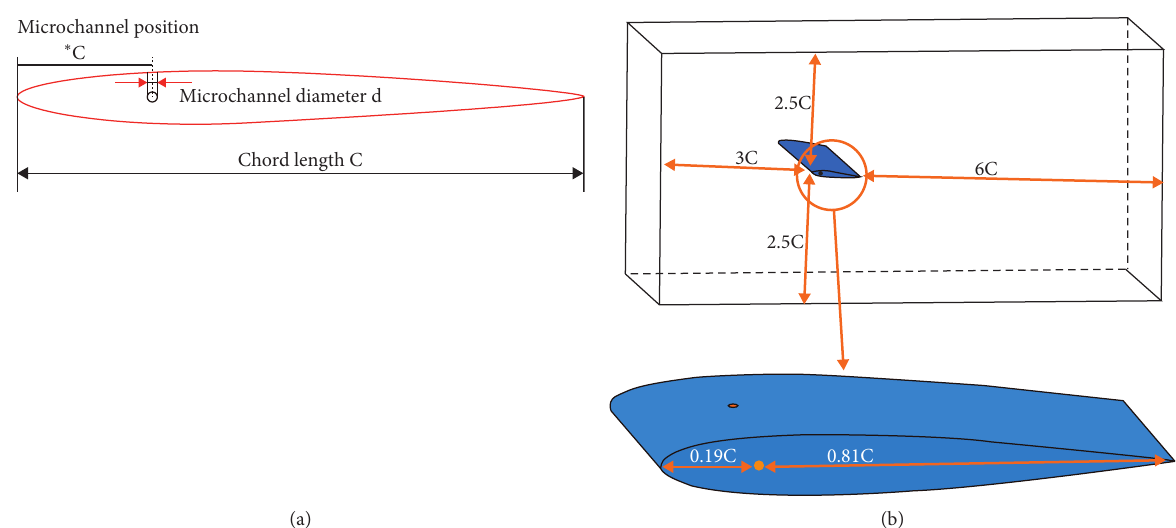
Figure 1: Geometrical model. (a) Structural dimension diagram. (b) Schematic diagram of NACA0012 computing